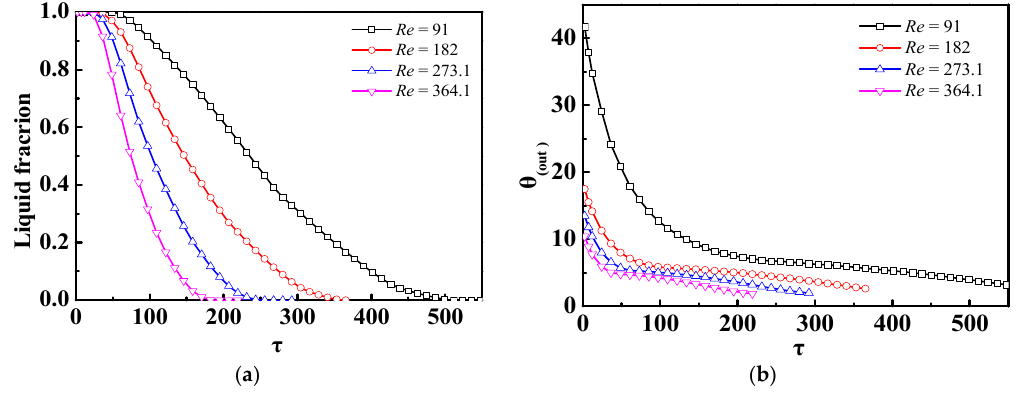
Figure 11. ( a ) Liquid fractions of the m-PCMs and ( b ) dimensionless outlet temperature as a function of dimensionless time at different Re numbers.